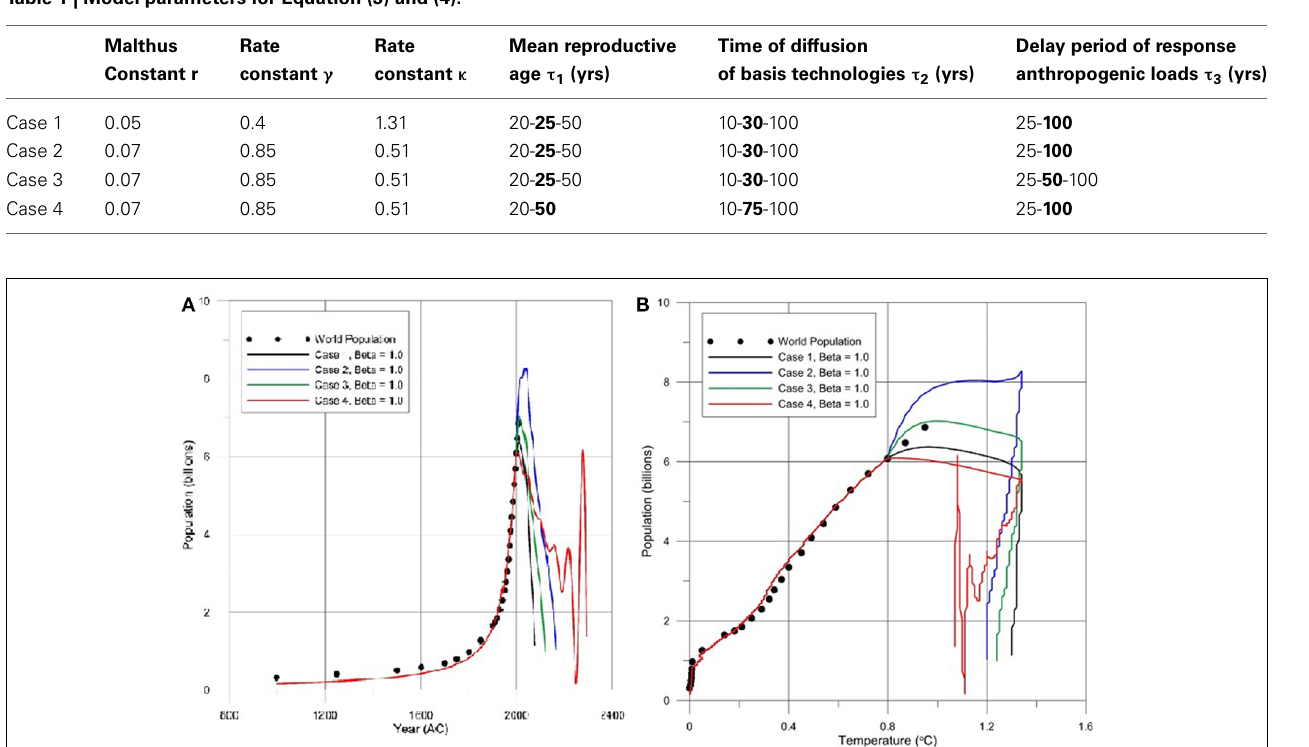
Table 1 | Model parameters for Equation (3) and